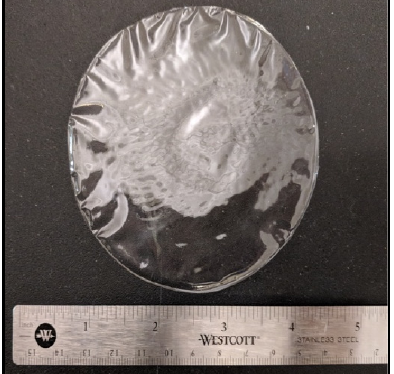
Figure 1. Image of PVA film.